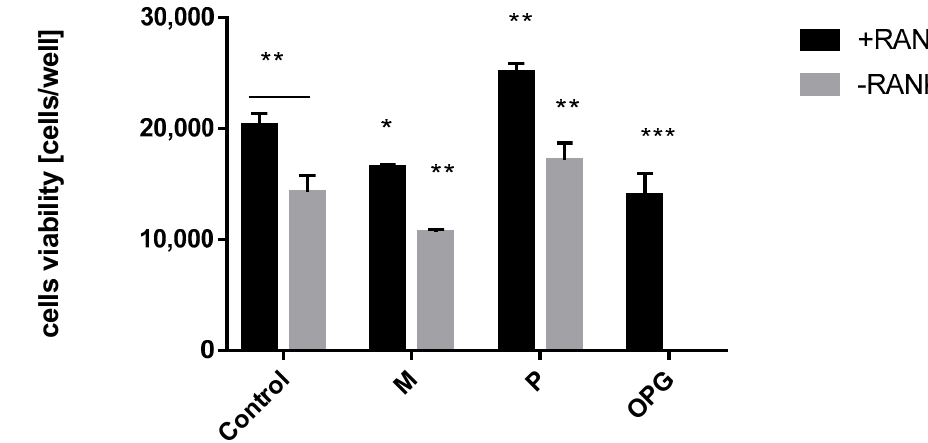
Figure 1. +RANKL and -RANKL induced T47D cells proliferation upon mifepristone (M, 1200 nM), progesterone (P, 1200 nM) and OPG treatment. Data represent the mean ± SD ( n = 3 ). p values correspond to controls with statistically significant differences: * p ≤ 0.05, ** p ≤ 0.01, *** p ≤ 0.001 (two-way ANOVA variance, multiple comparison of the tested groups vs. control group, separately for +RANKL and -RANKL conditions).